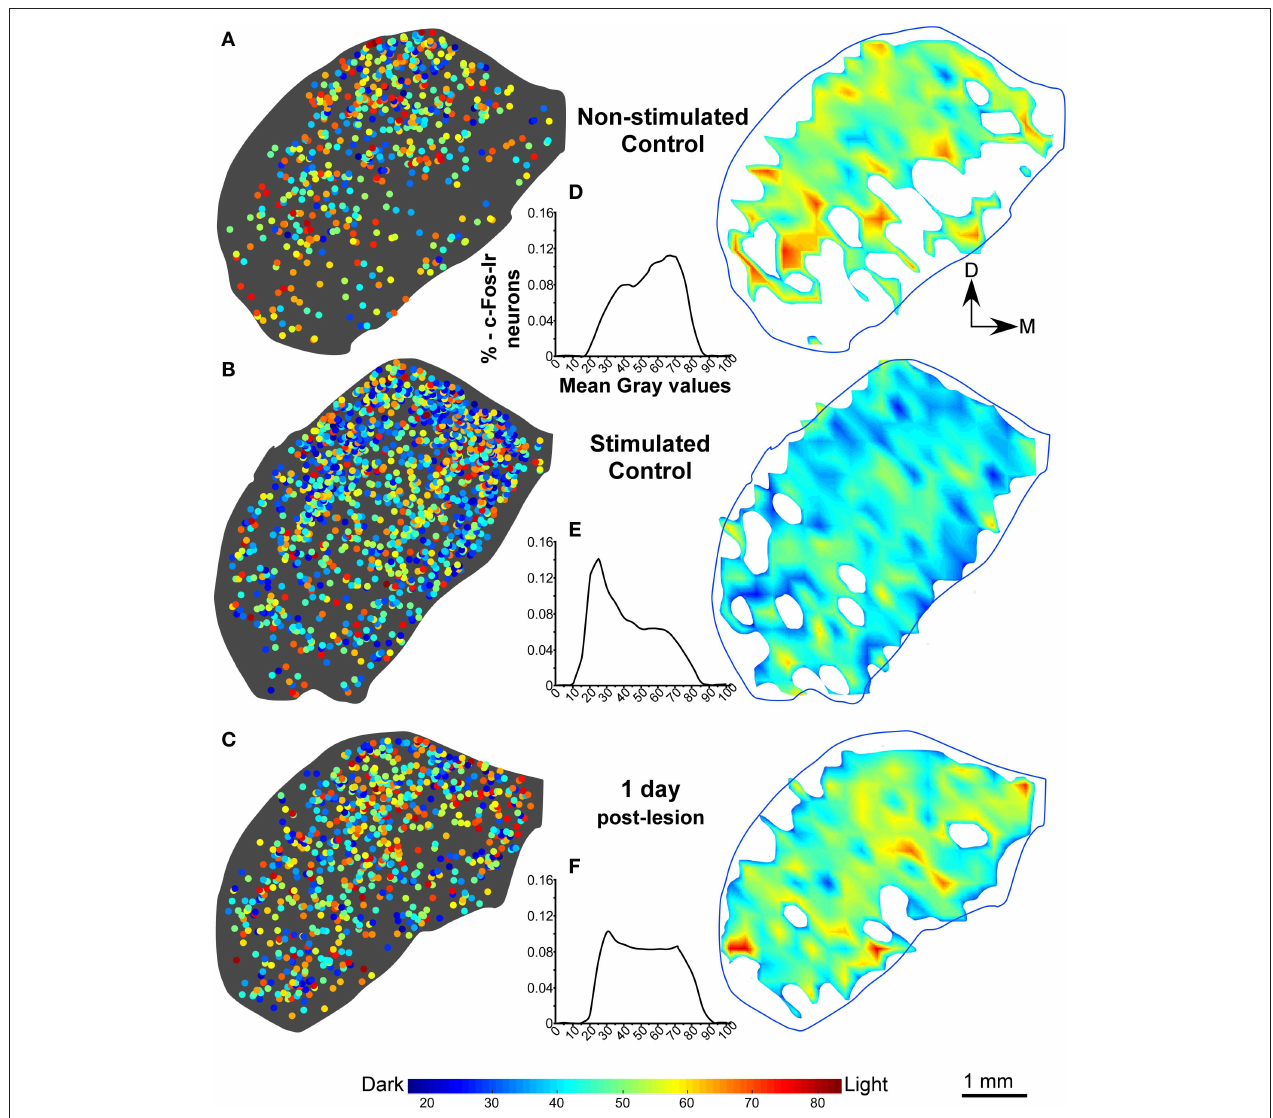
including the dorsal cortex (DCIC). (C) c-Fos labeling density diminishes after stimulation at 1 day post-lesion. As shown in the interval histograms in (D,e) , gray intensity values of individual c-Fos immunoreactive nuclei shift toward more intense (higher numerical) values between non-stimulated and stimulated controls. After 1 day post-lesion, values are lower than in stimulated controls and the histogram curve (F) is more flat than in stimulated control